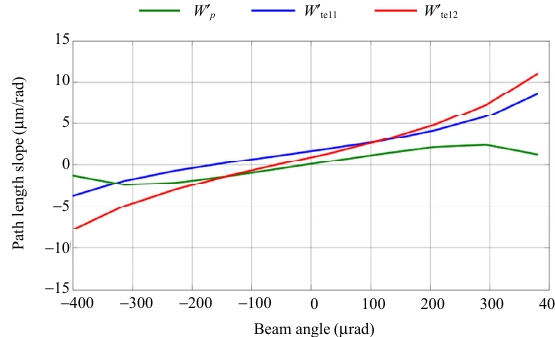
Fig. 10 Simulation results of path length slope caused by three different situations,